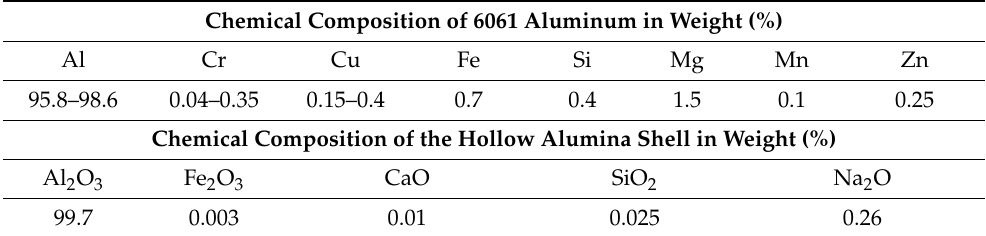
Table 1. Chemical composition of the 6061 aluminum-based syntactic foam (supplier data).